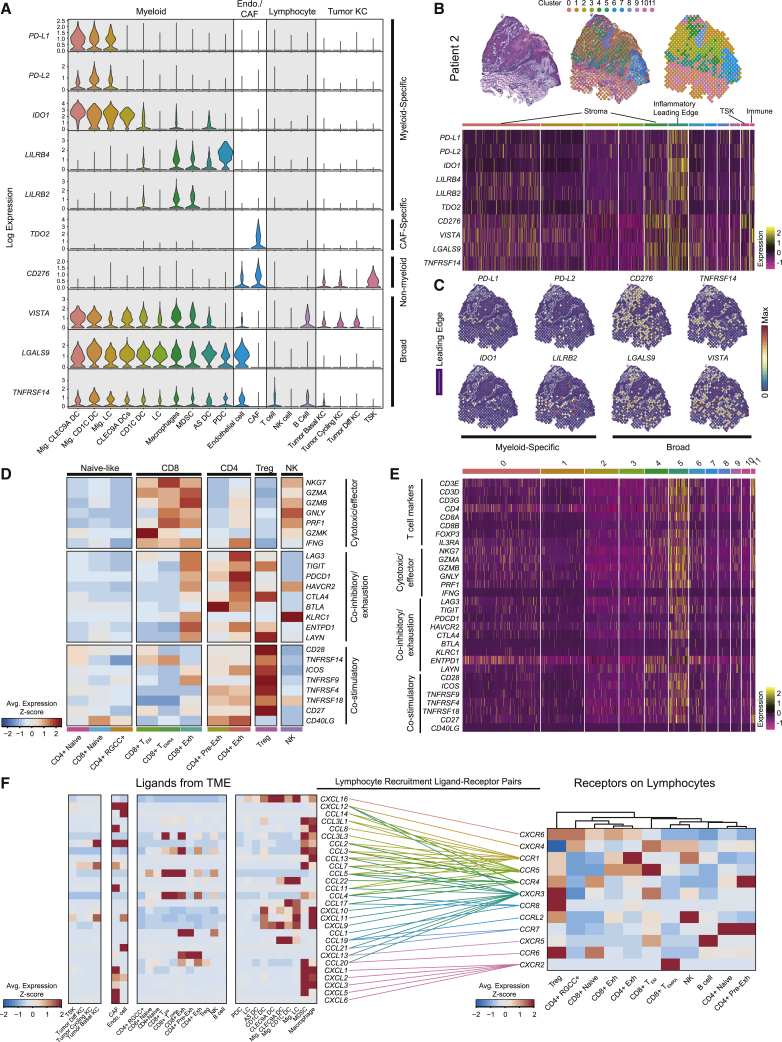
The Immune Landscape of cSCC(A) Violin plots of select immunosuppression-associated gene expression across cell types of the TME from scRNA-seq data.(B) Top, spatial transcriptomics (ST) cluster map from patient 2. Bottom, heatmap of select immunosuppression-associated gene expression across spatial transcriptomic spots grouped by cluster.(C) Feature plots of select immunosuppression-associated genes by ST.(D) Z-scored mean log expression heatmap of genes associated with cytotoxicity, exhaustion, and co-stimulatory function across T cell subsets in scRNA-seq data.(E) Heatmap of expression of T cell marker genes, and genes associated with cytotoxicity, exhaustion, and co-stimulatory function in ST spots grouped by cluster.(F) Left, Z-scored mean log expression heatmap of chemokine genes across cell types from scRNA-seq data. Right, Z-scored mean log expression heatmap of chemokine receptor genes across lymphocyte cell types from scRNA-seq data. Colored lines connect matching ligands for each chemokine receptor.Pre-Exh, pre-exhausted; TEM, T effector memory; TEMRA, T recently activated effector memory; Mig., migrating; DC, dendritic cell; CAF, cancer-associated fibroblast; KC, keratinocyte. See also Figure S4.